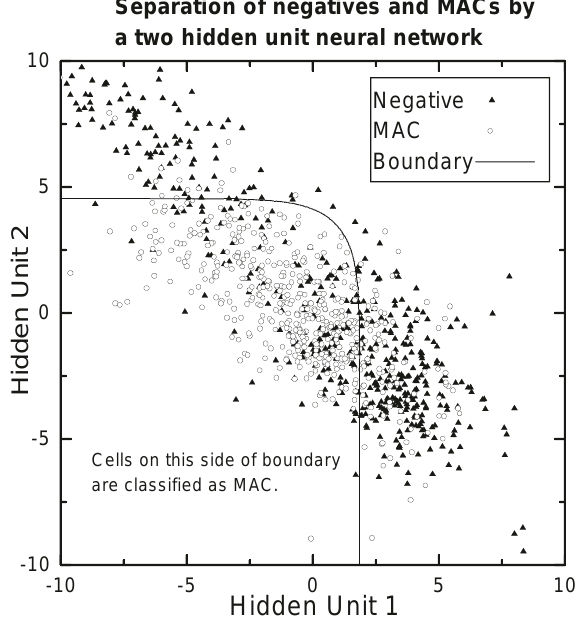
Fig. 4. The projection of the training data along the vectors that make up a two hidden unit neural network is shown. This network correctly classifies 71.9% of the test data. For clarity, only every eighth cell is shown in the plot. The decision bounday for this network is the curved line that separates cells in the lower left quadrant from the